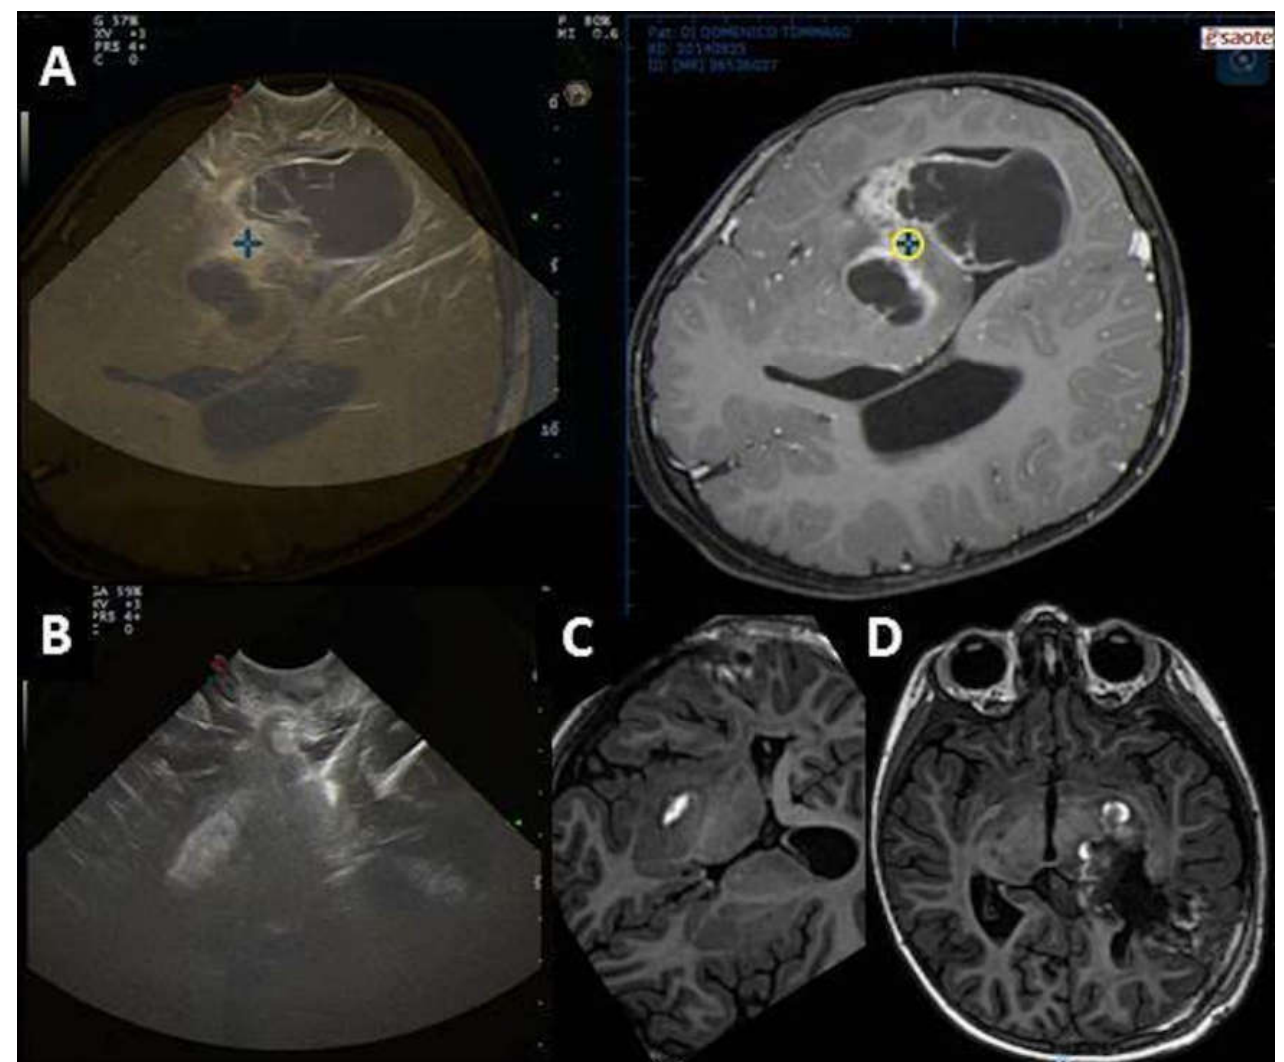
Figure 5. Neuronavigated Pre-IOUS showing large intraventricular tumor ( A ). Post-IOUS docu- mented a focal thalamic hemorrhage ( B ). Postoperative MR confirmed this finding ( C ) and the complete resection of the tumor ( D ).